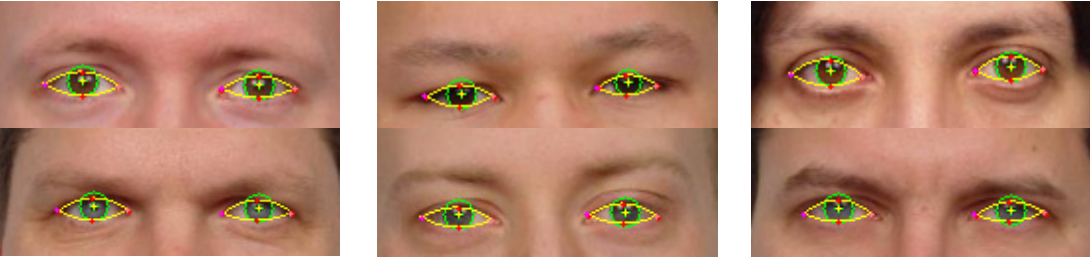
Figure 21. Eye shape segmentation on the IMM face database. Table 4. Performance of the eye shape segmentation algorithm the UMFD and IMM datasets.